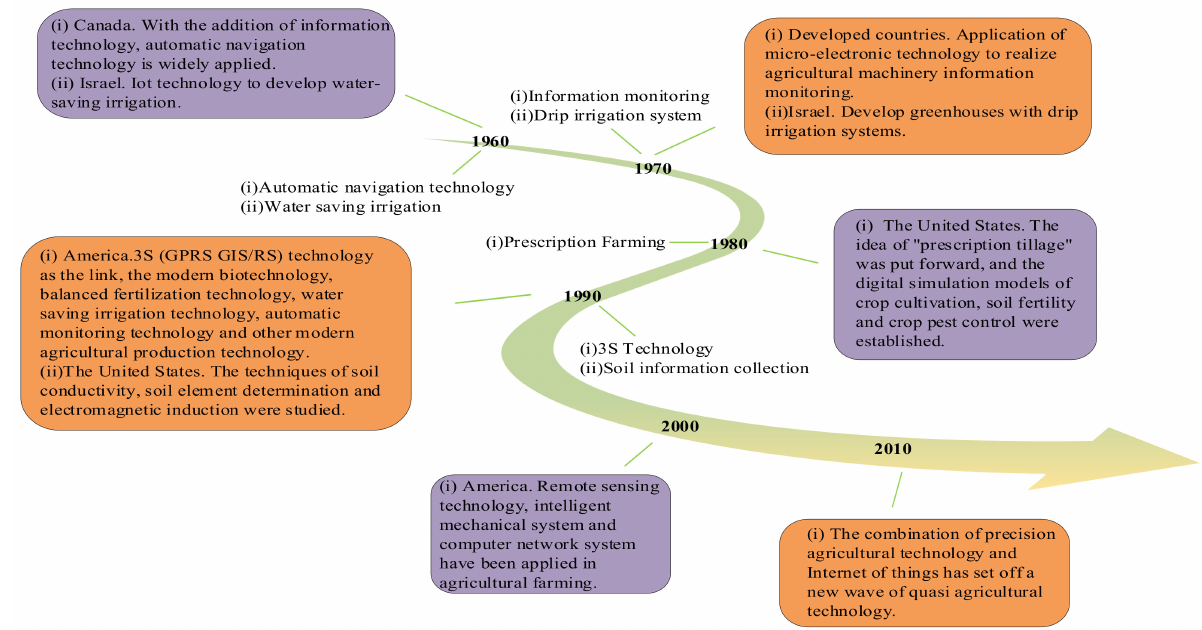
Figure 15. Time and derivation of precision agriculture